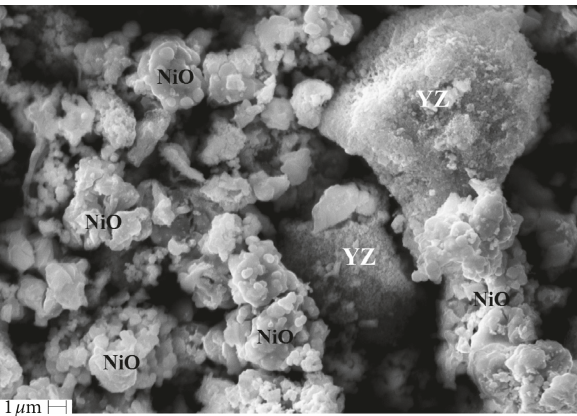
Figure 6: SEM image (